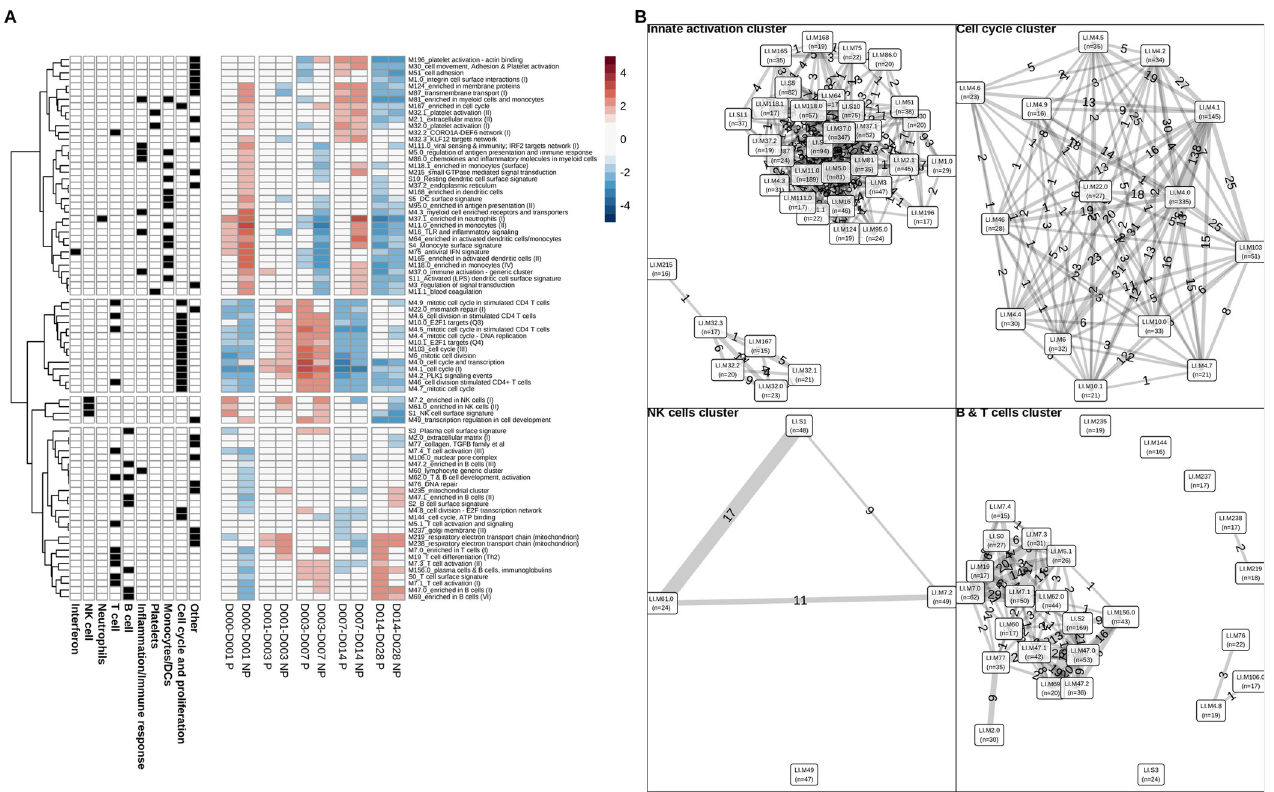
Fig 3. Gene set enrichment analysis after the first immunization in P and NP subjects. A . Heatmap of GSEA normalized enrichments scores (NES) derived from BTM expression changes over each time interval. Red represents activated BTMs and blue represents down-regulated BTMs. BTM clusters derived from hierarchical clustering are indicated by spaces between heatmap rows. B . Relationships between BTMs within the four identified clusters. Clusters are laid out left to right and top to bottom to match top-to-bottom order of clusters in A . BTMs with shared genes are connected by lines, with thicknesses and labels corresponding to numbers of shared genes, and node sizes corresponding to the number of BTM genes genes. Predominant cell-type module annotations for each cluster are shown.